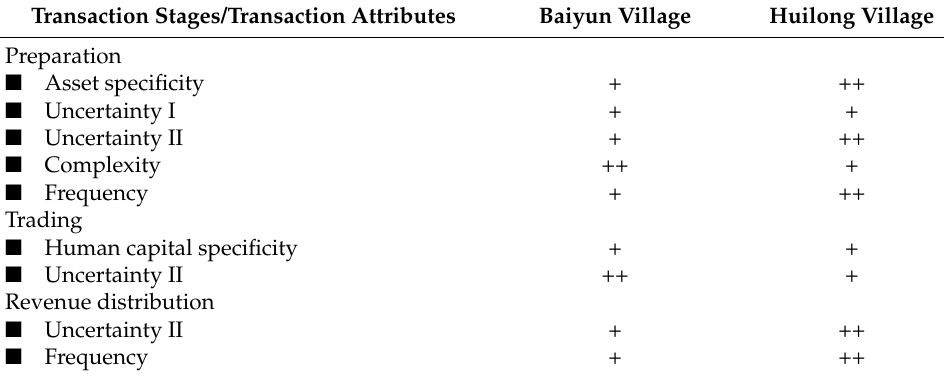
Table 5. Comparison of the CCCL projects between Baiyun Village and Huilong Village in terms of the transaction attributes at different transaction